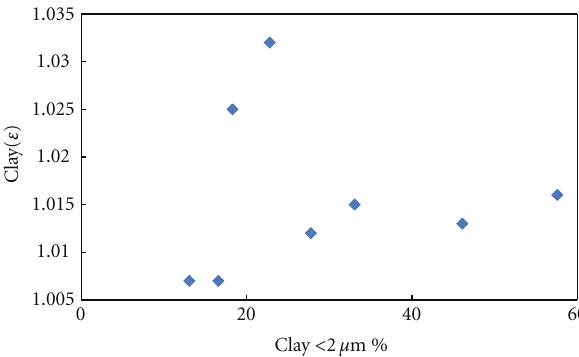
Figure 10: TIR-derived Clay( ε ) mineral index versus the particle size determined clay% of the eight natural Tick Hill samples.